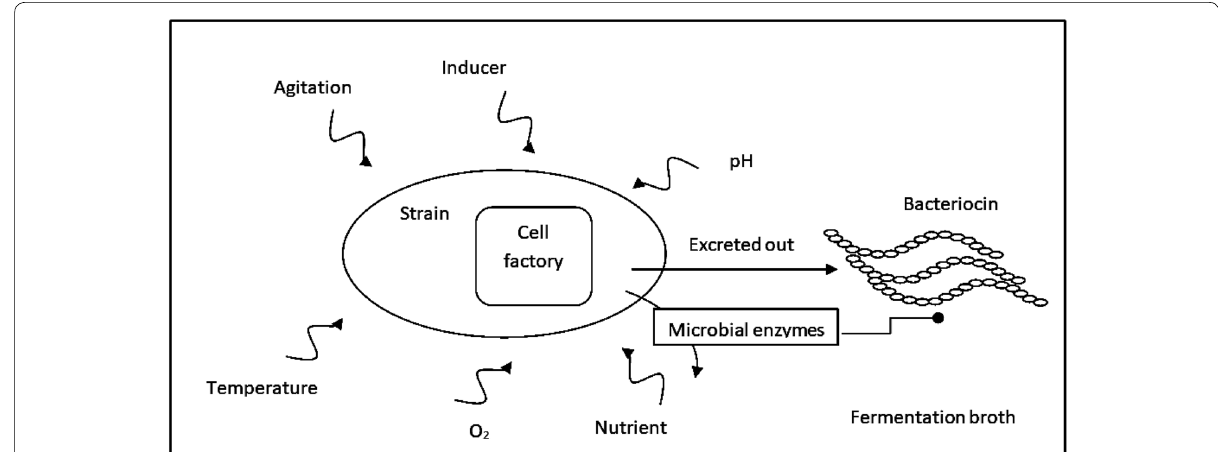
Fig. 1 Interaction of several fermentation factors during bacteriocin production. The cell factory comprised several components such as nucleus, ribosome and